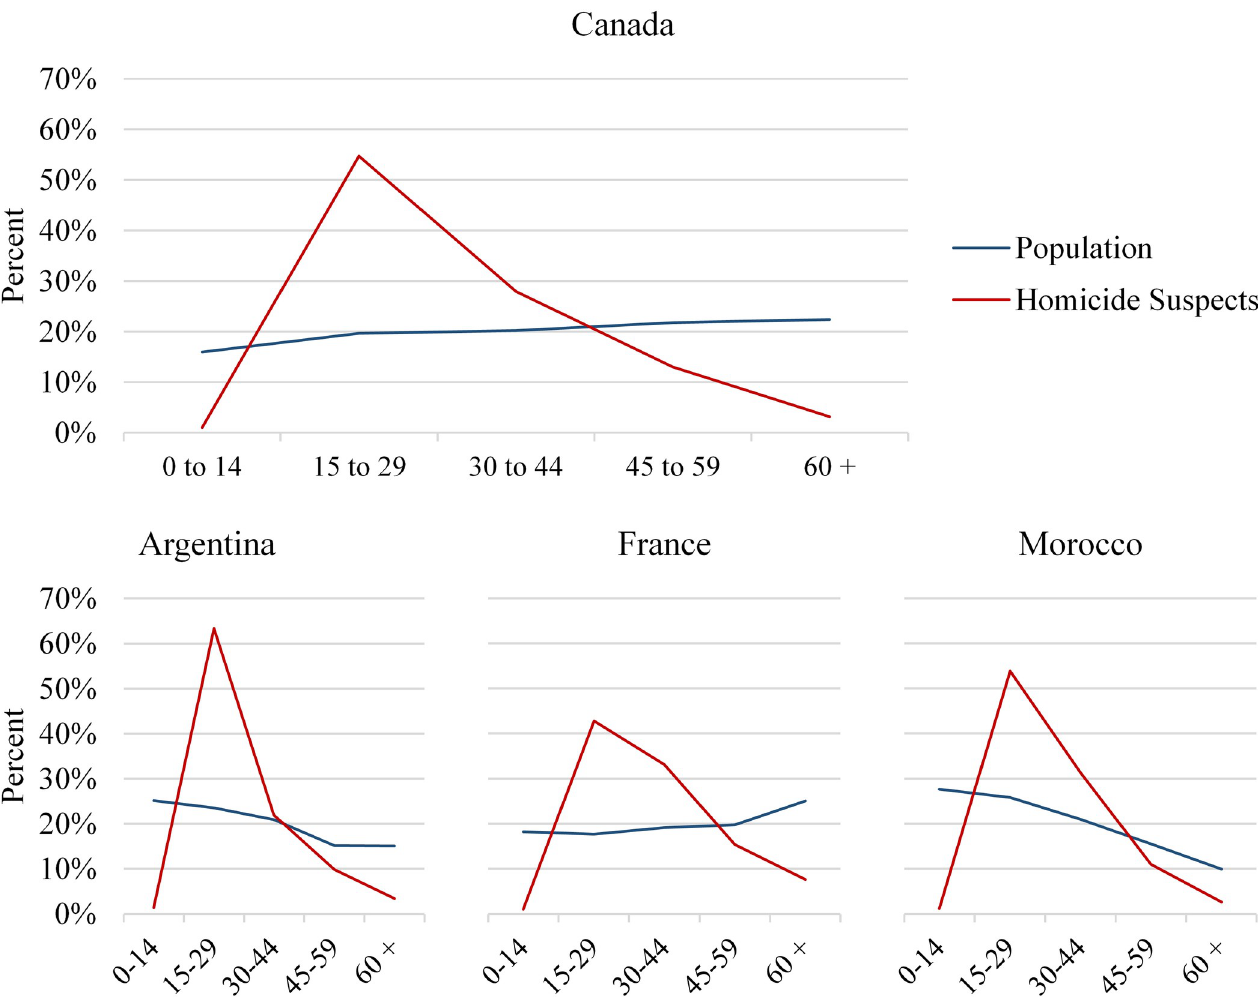
Fig 1. Percent distribution of persons brought into formal contact with the Criminal Justice System for homicide and of the population by age group– 2015. Shown is the age distributions of persons brought into formal contact with the Criminal Justice System for homicide (homicide suspects) and the age distribution of the population of Canada, Argentina, France and Morocco in 2015. Data are from the United Nations Office on Drugs and Crime.